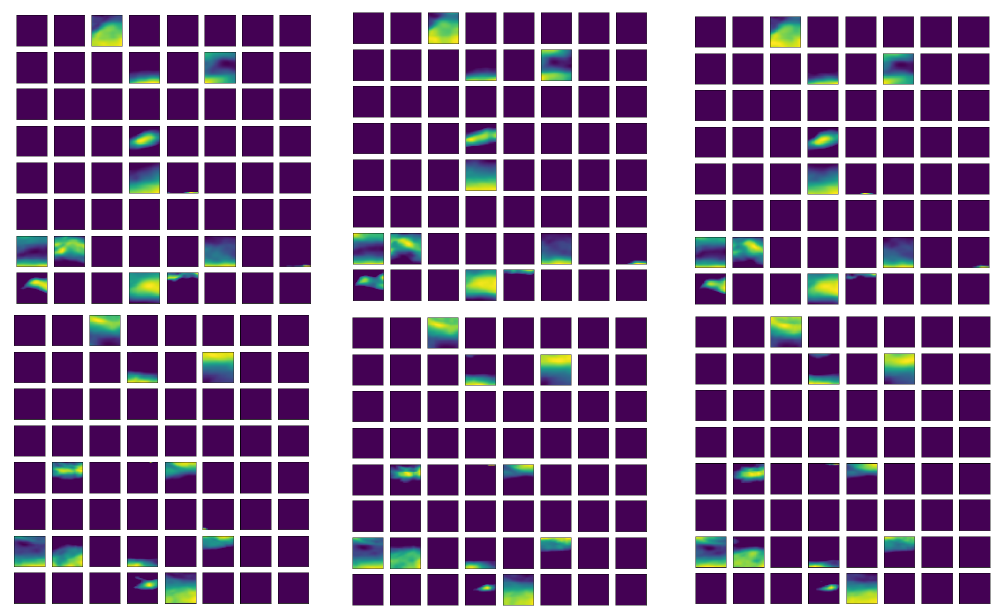
Figure 7. Same as Figure 6 but for zonal component of wind (variable u).